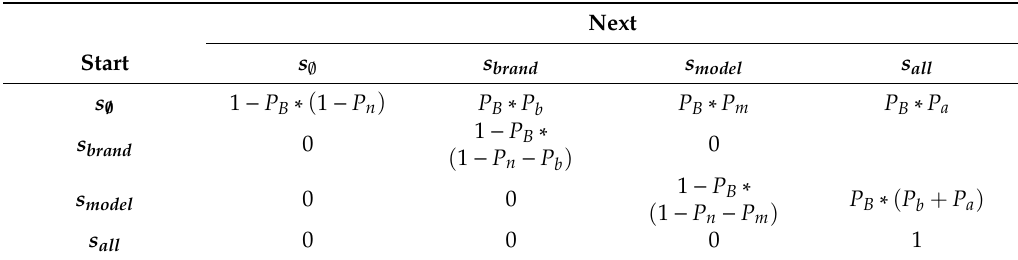
Table 2. State transition probability